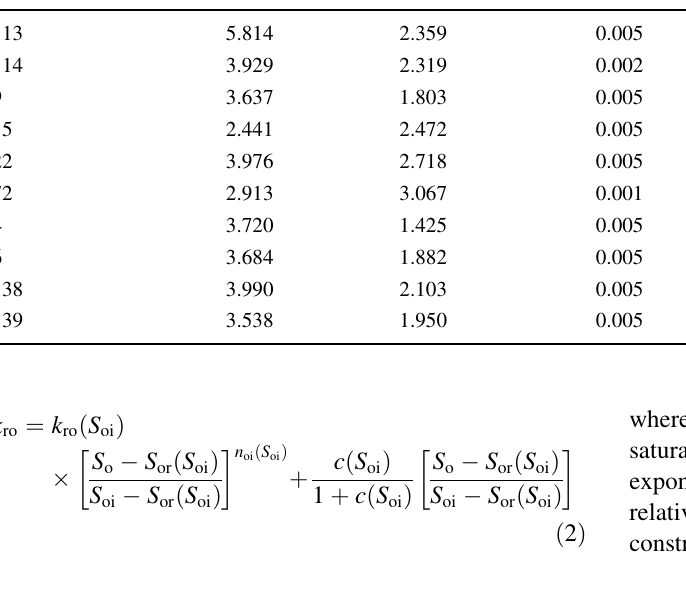
Table 6 Fitting parameters of K r correlation for sample plugs Sample